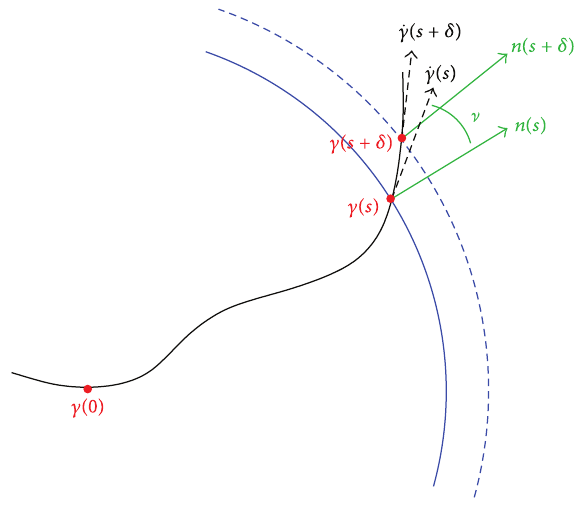
Figure 7: TGLL implies TCGL: